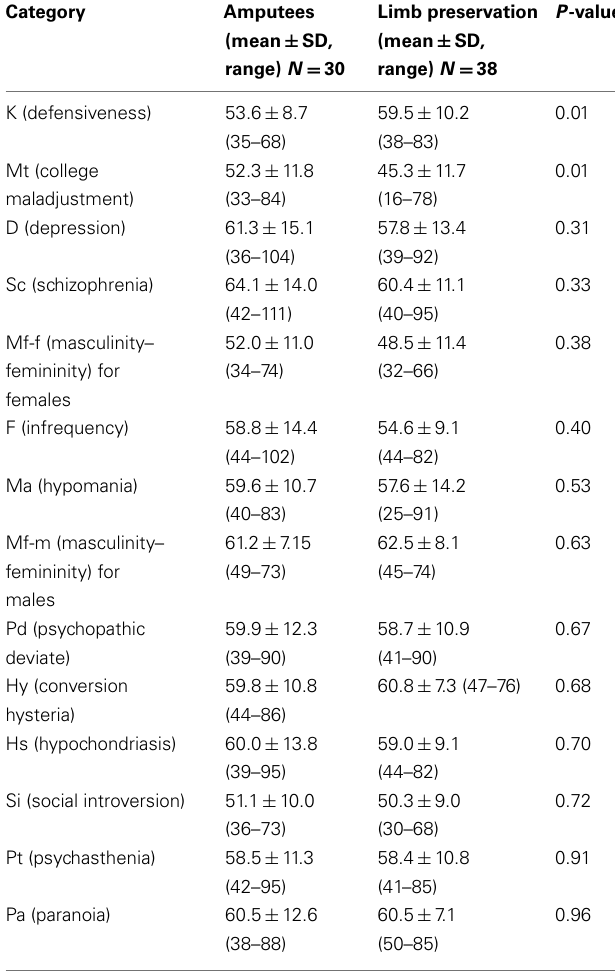
Table 3 | Comparison of the adult MMPI of patients with amputation and limb